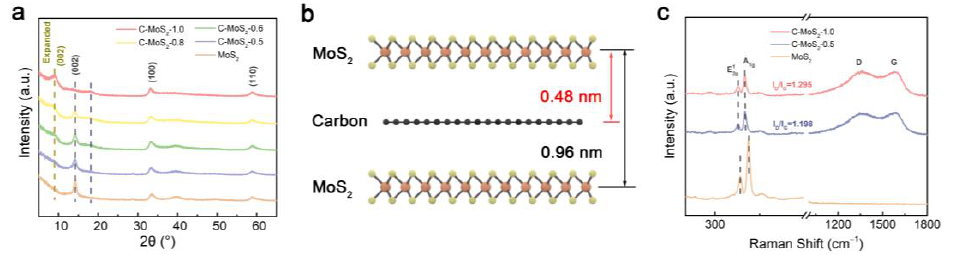
Figure 1. Characterization of samples. ( a ) XRD patterns of the MoS 2 and C-MoS 2 samples. ( b ) Crystalline structure of C-MoS 2 -1. ( c ) Raman spectra of the MoS 2 and C-MoS 2 samples. Raman spectra was used to further characterize the composition and crystallinity in- formation of the MoS 2 and C-MoS 2 samples. As shown in Figure 1c, two characteristic peaks located at around 384 and 413 cm −1 of bare MoS 2 were attributed to the Mo-S in-